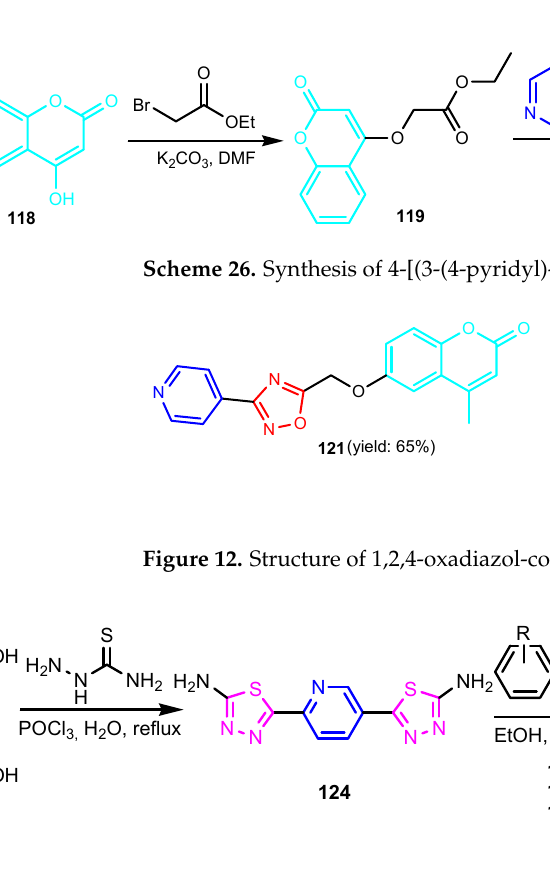
Scheme 27. Synthesis of imidazo[2,1b]-1,3,4-thiadiazoles 120a − 120e [56].